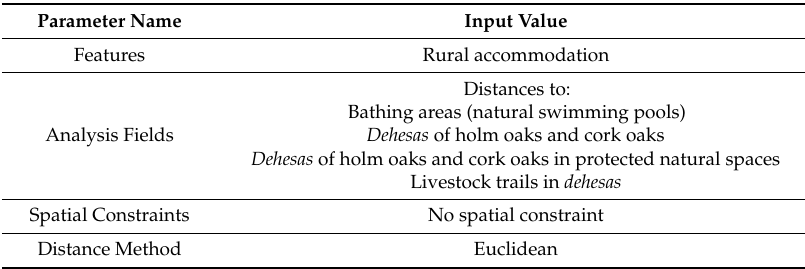
Table 3. Parameters used in the analysis of